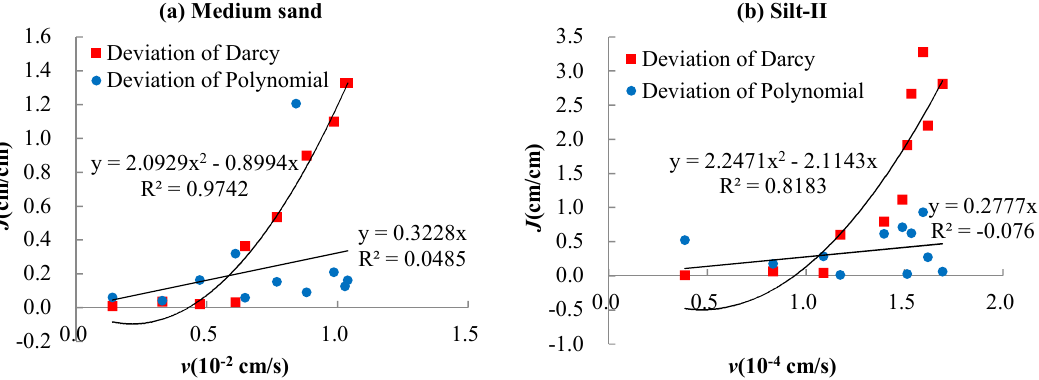
Figure 8. Relationship between average velocity of experimental results and error from Darcy’s law.